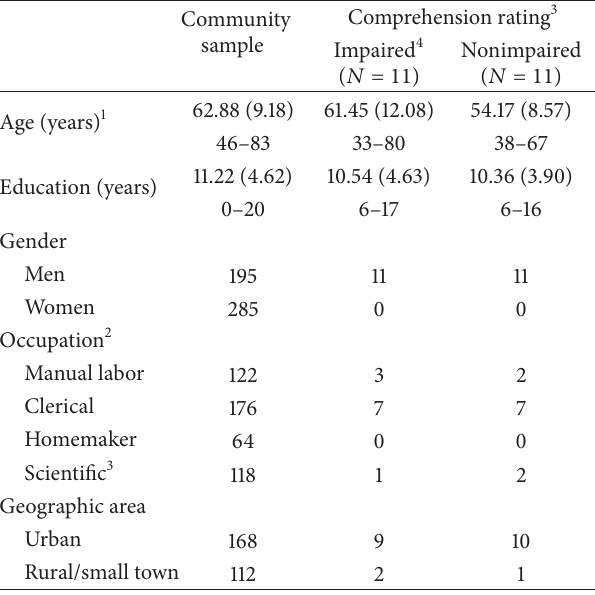
Table 1: Demographic characteristics of the community and patient